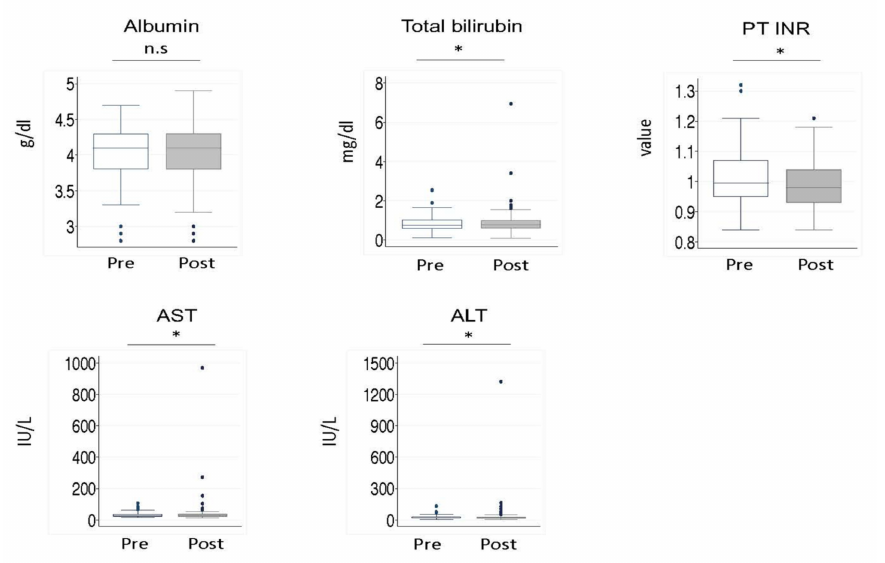
Figure 4. Changes in serum albumin (n = 91), total bilirubin (n = 91), prothrombin-time INR (n = 54), AST (n = 92), and ALT (n = 92) levels after vaccination in patients with autoimmune diseases. *: p < 0.05, n.s.: not